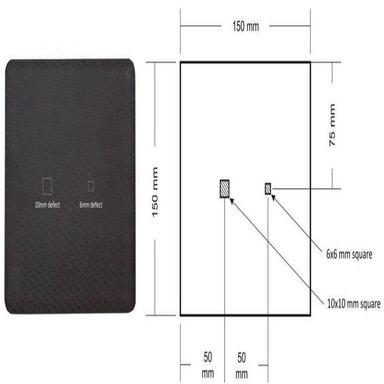
Dimensions of the panels produced, showing the kiss-bond area locations.